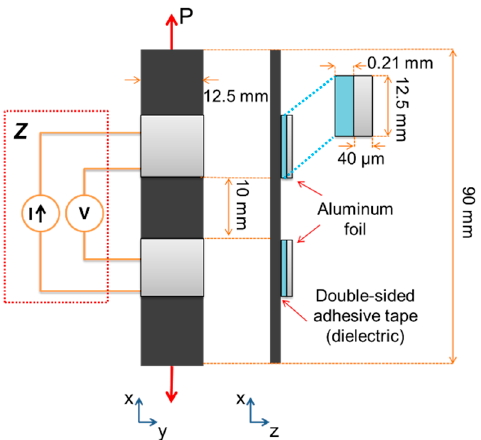
Figure 2. Specimen instrumented for piezoimpedance characterization in the dielectric configura ‐ tion.